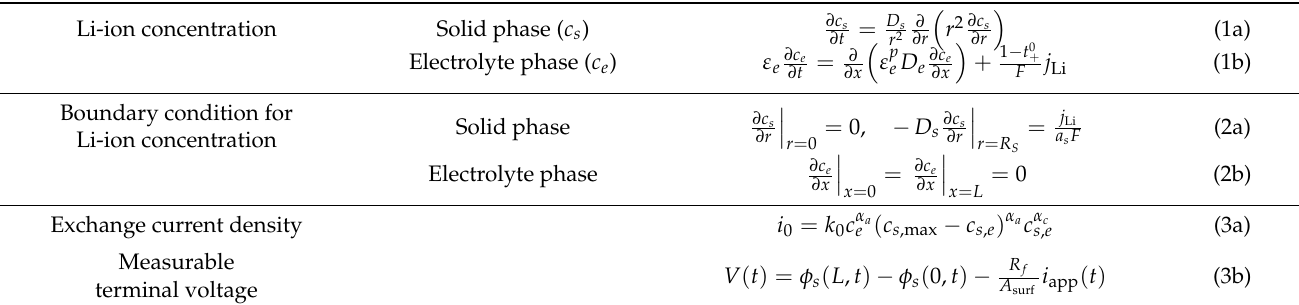
Figure 2. Schematic of the LiB model during charging. Table 2. Governing equations of the DFN model.